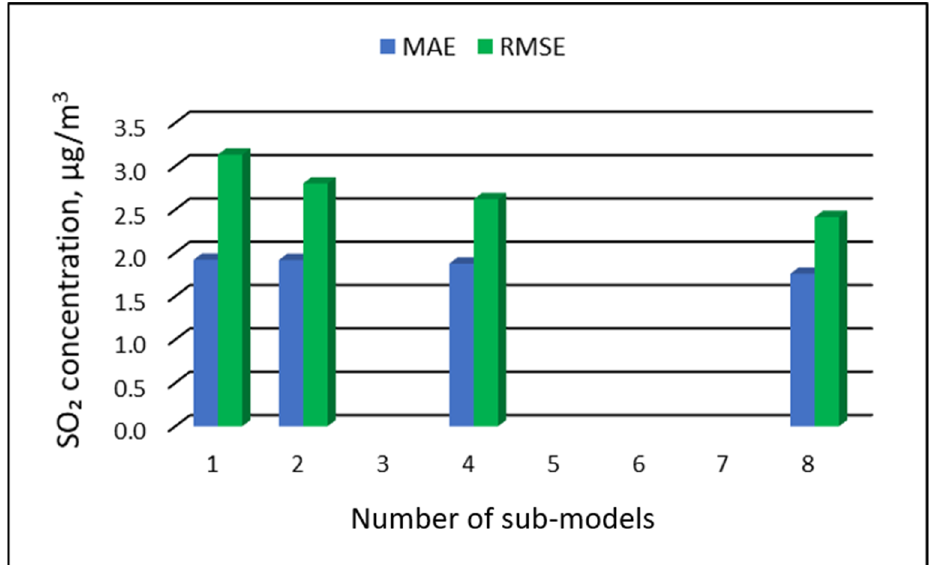
Figure 18. Overall MAE and RMSE values for SO 2 concentration prediction in PVS models depending on the number of created sub-models, Z ł oty Potok.